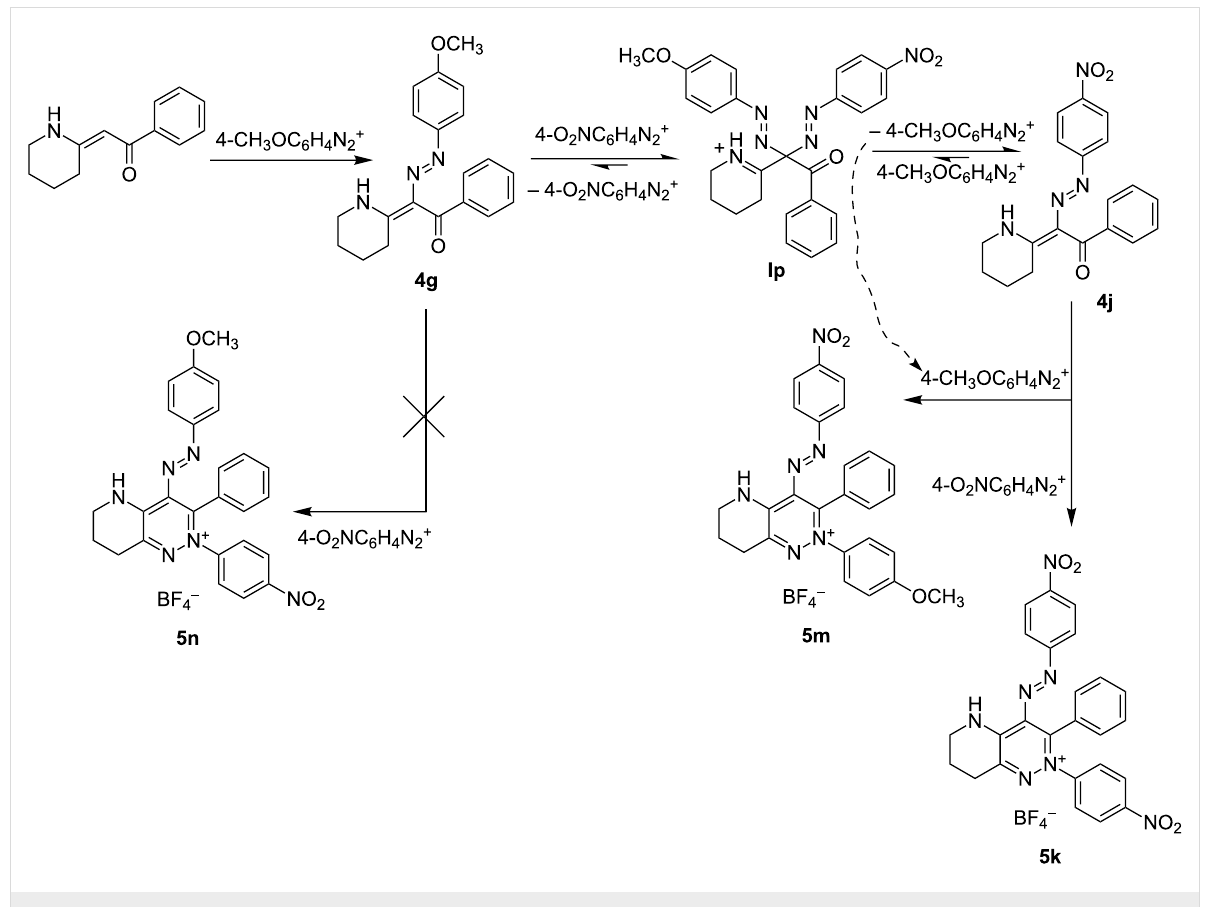
Scheme 6: An attempt at synthesis of 5n and possible explanation of the failure.